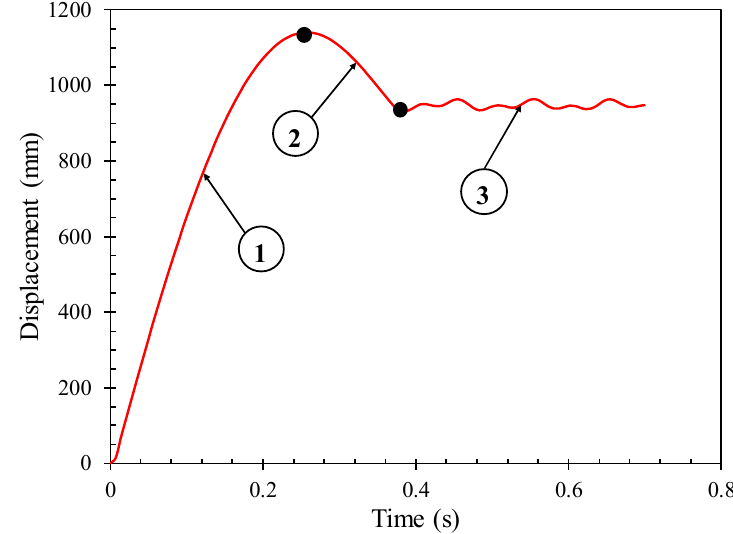
Figure 14. Displacement-time response of model RS-3.